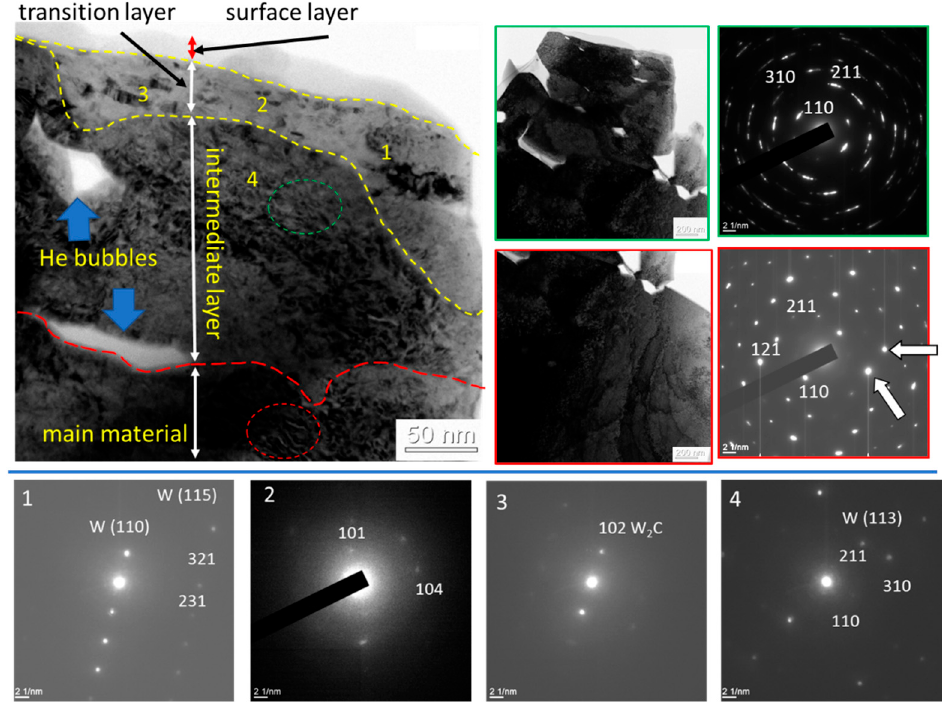
Figure 9. An electron microscopic image of the nanostructured surface layer of sample No. 5; a is a light field; 1–4 areas marked with red and green are microelectronograms obtained from these areas with numbers 1–4. Area No.1-W; No.2-W + W 2 C; No.3-W + W 2 C; No.4-W; green boundary, reflex [110]W (bcc lattice, а = 0.3158 nm); red boundary, reflex [211]W (plane of 113 type).